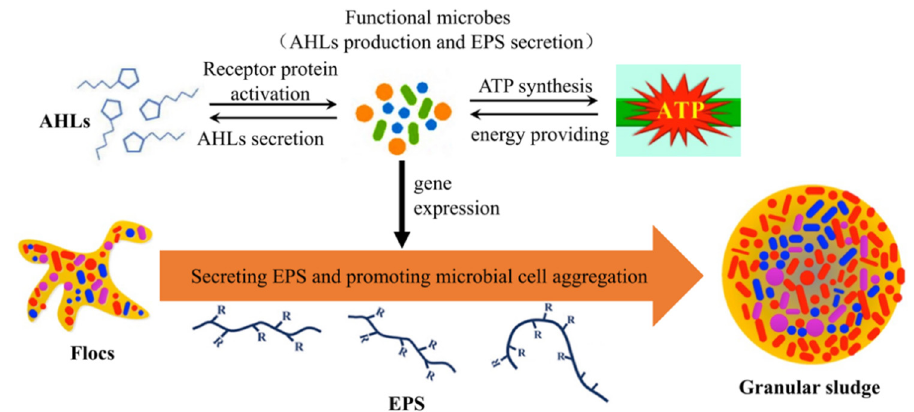
Figure 5. Regulation of QS in sludge granulation. Adapted from reference [74,75] (copyright reserved Elsevier, 2019, significantly modified).